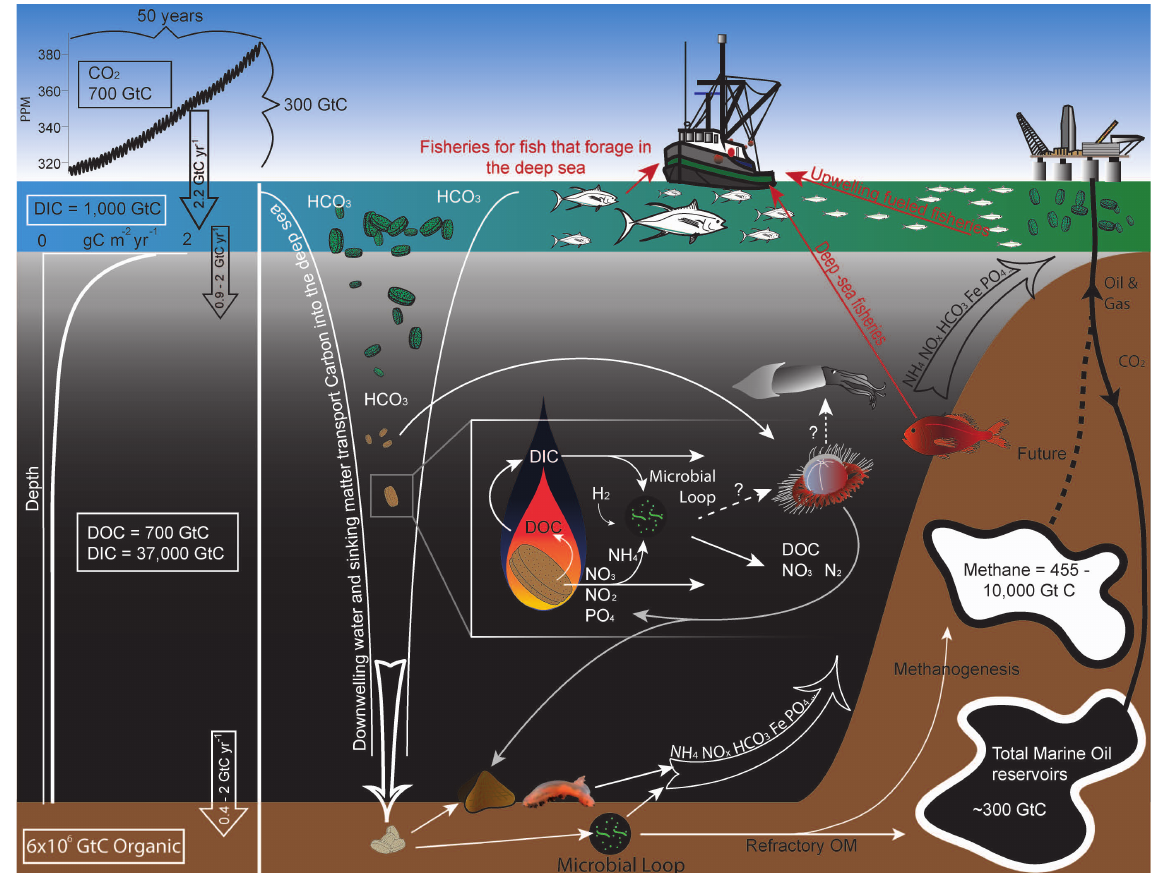
Figure 2. Schematic of carbon flow and a subset of the resources and functions of the deep sea. Data include the Keeling and Martin curves (Martin, 1987) and values from Longhurst (1991), Sabine and Feely (2007), Canadell et al. (2007), and the US EPA. Arrows represent the flow of matter or carbon and the upwelling of nutrients. Dotted lines are potential or unquantified flows. NO x = NO 2 and NO 3 . Not to